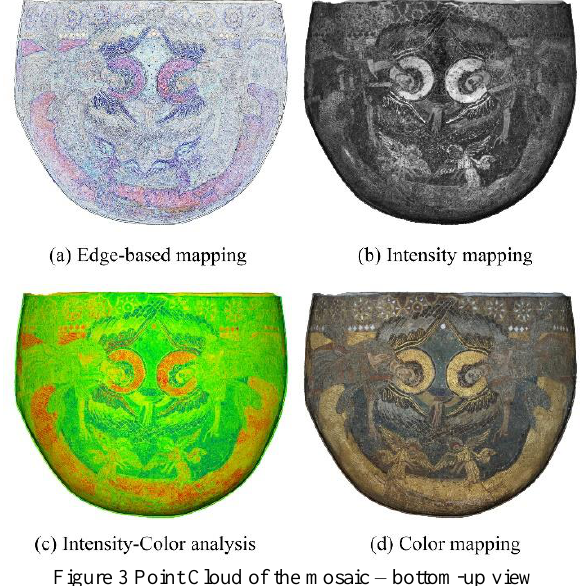
Figure 3 Point Cloud of the mosaic – bottom-up view Finally, the different signatures are fused as in (Poux et al., can be extracted.